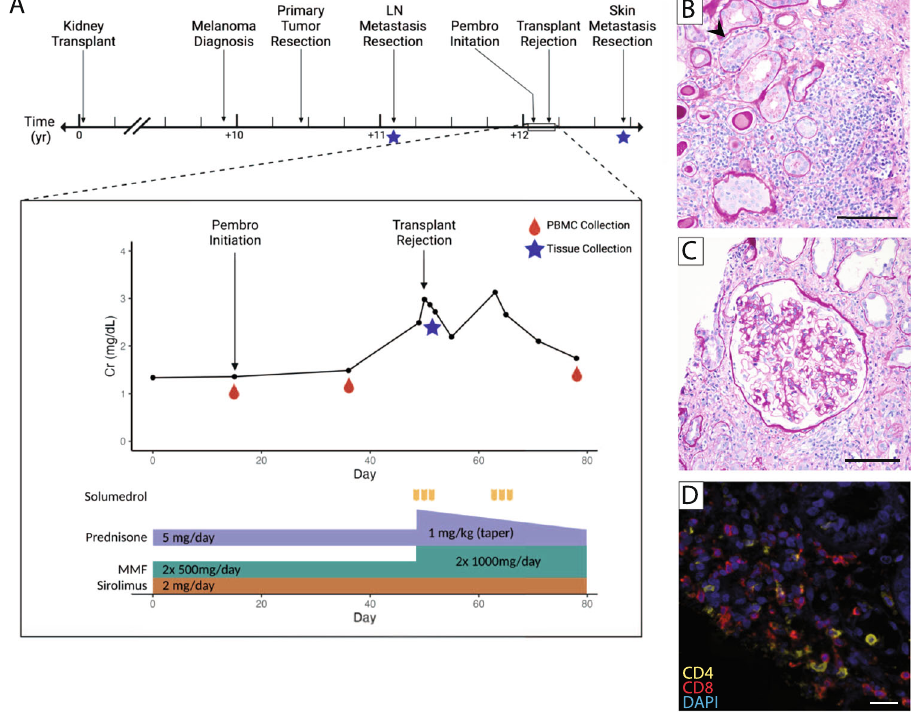
Fig. 1 | Case of kidney transplant rejection following immune checkpoint inhibitor treatment. A Timeline of events, including notation of samples col- lected. The callout box denotes the timeline of the medication regimen and crea- tinine (Cr) levels during immune checkpoint inhibitor therapy. B – D . Histology of immunecellin fi ltrationintheallograftbiopsy. B Periodicacid – Schiff(PAS)stainof allograft biopsy showing prominent interstitial in fl ammation (i3), focal tubulitis